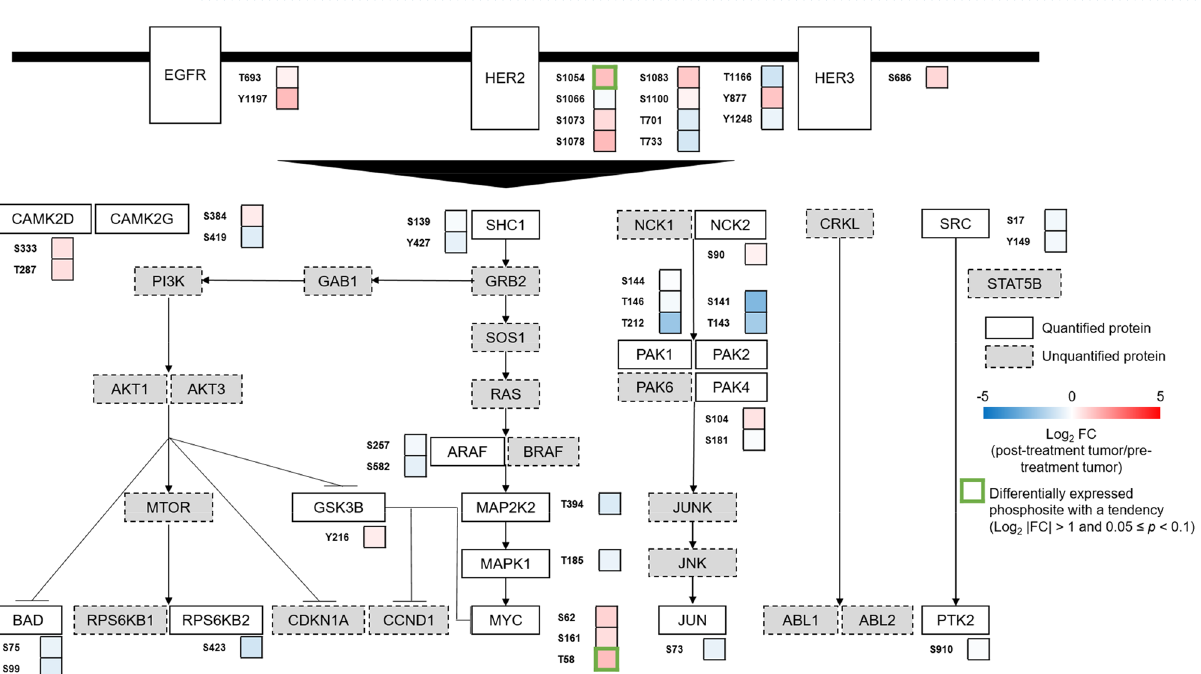
Figure 4. Dynamics of phosphosites in the ErbB pathway (between pre- and post-treatment the HER2-positive gastric cancer groups). Proteins in the ErbB signaling pathway are selected from the KEGG database 65 . Proteins with quantified phosphosites are shown as white boxes with solid lines. Proteins without quantified phosphosites are shown as grey boxes with dotted lines. Differentially expressed phosphosites with a tendency (log 2 |FC| > 1 and and 0.05 ≤ p < 0.1) are depicted by a green